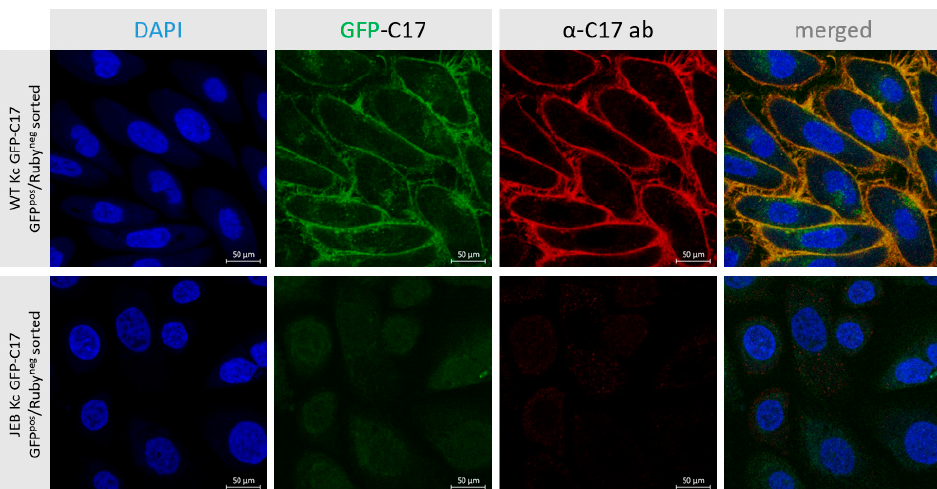
Figure 4 . GFP-C17 expression and localization in WT and JEB keratinocytes upon GFP pos /RFP neg sorting. Fluorescence (GFP) and immunofluorescence (C17) microscopy revealed the accurate deposition of the GFP-C17 fusion protein within the plasma membrane of GFP-C17-sorted WT Kc, whereas in sorted JEB Kc the GFP-C17 mut expression was hardly detectable within the cytoplasm. Merging of both fluorescence channels revealed a clear overlap in the expression of plasma membrane-integrated immunolabelled C17 (C17 and GFP-C17) and GFP-C17 proteins directly emitting green fluorescence. Nuclei were stained with 4’, 6-Diamidino-2-phenylindol (DAPI, blue). 2.3. COL17A1 Repair via CRISPR/Cas9 Restores GFP-C17 Expression in JEB Kc